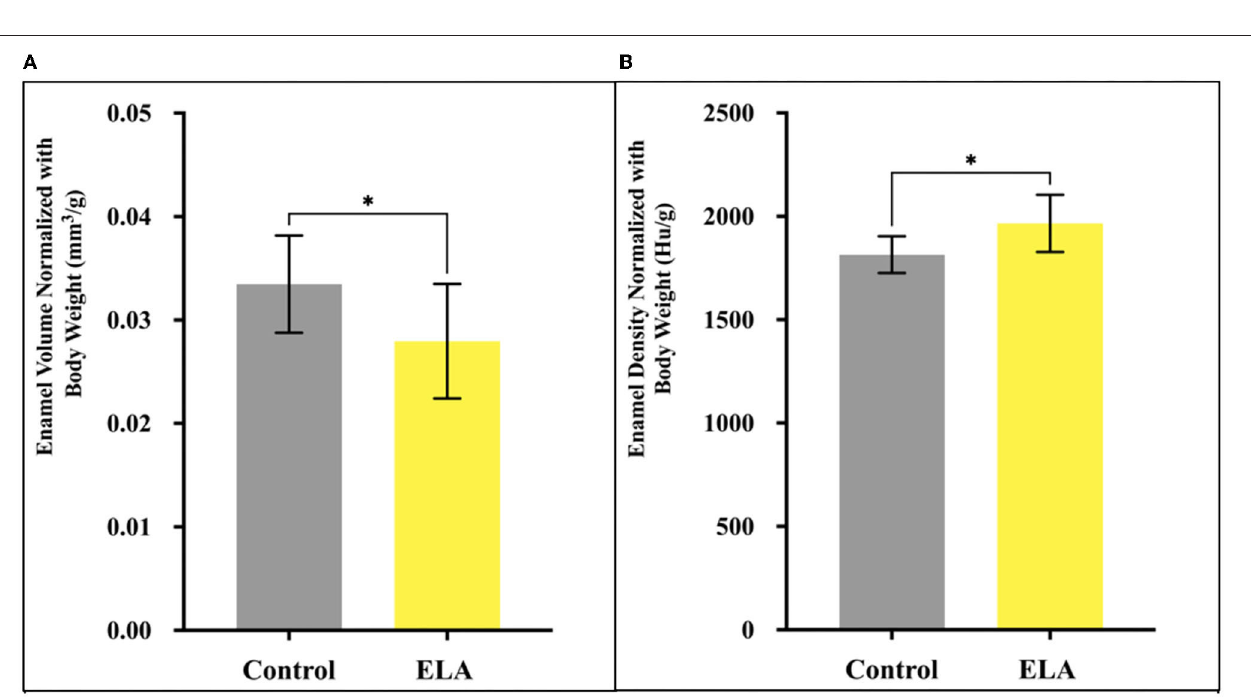
FIGURE 2 | Mineralized enamel volume and relative density in molars from P12 mice, normalized for body weight. (A) Enamel volume was significantly less in ELA ( n = 10) as compared to controls ( n = 10). (B) Enamel density was significantly higher in ELA mice as compared to controls * p < 0.05. Error bars: SD.